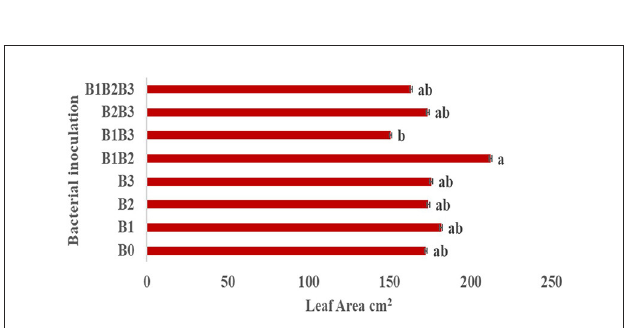
FIGURE5 Leaf area of inoculated maize plants. Values are presented as means ± standard error ( n = 24). Means with different letters are significantly different from each other according to Duncan Multiple Range test ( p ≤ 0.05).